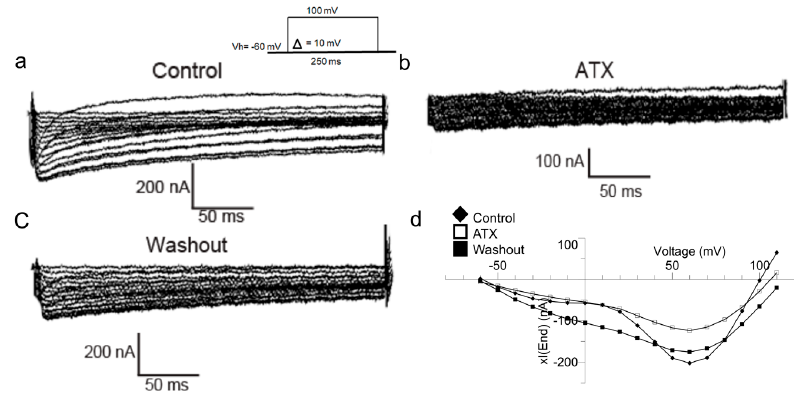
Figure 2. ATX inhibits Endogenous currents in Xenopus oocytes. TEVC currents recorded with [Na + ] (82.5 mM) in the bath. Current families traces in control conditions ( a ), in the presence of ATX ( b ) and after washout ( c ). Current-voltage relationships constructed using the current sizes of a, b and c families at different potential steps ( d ).